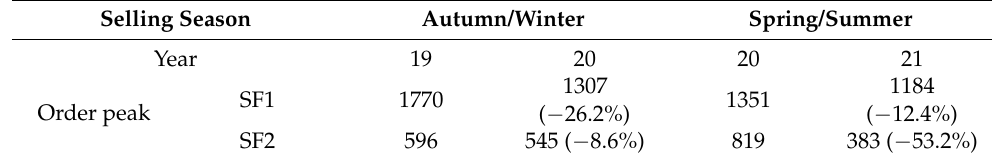
Table 2. Comparison between seasonal order peaks pre and post COVID-19 pandemic. Selling Season Autumn/Winter Spring/Summer